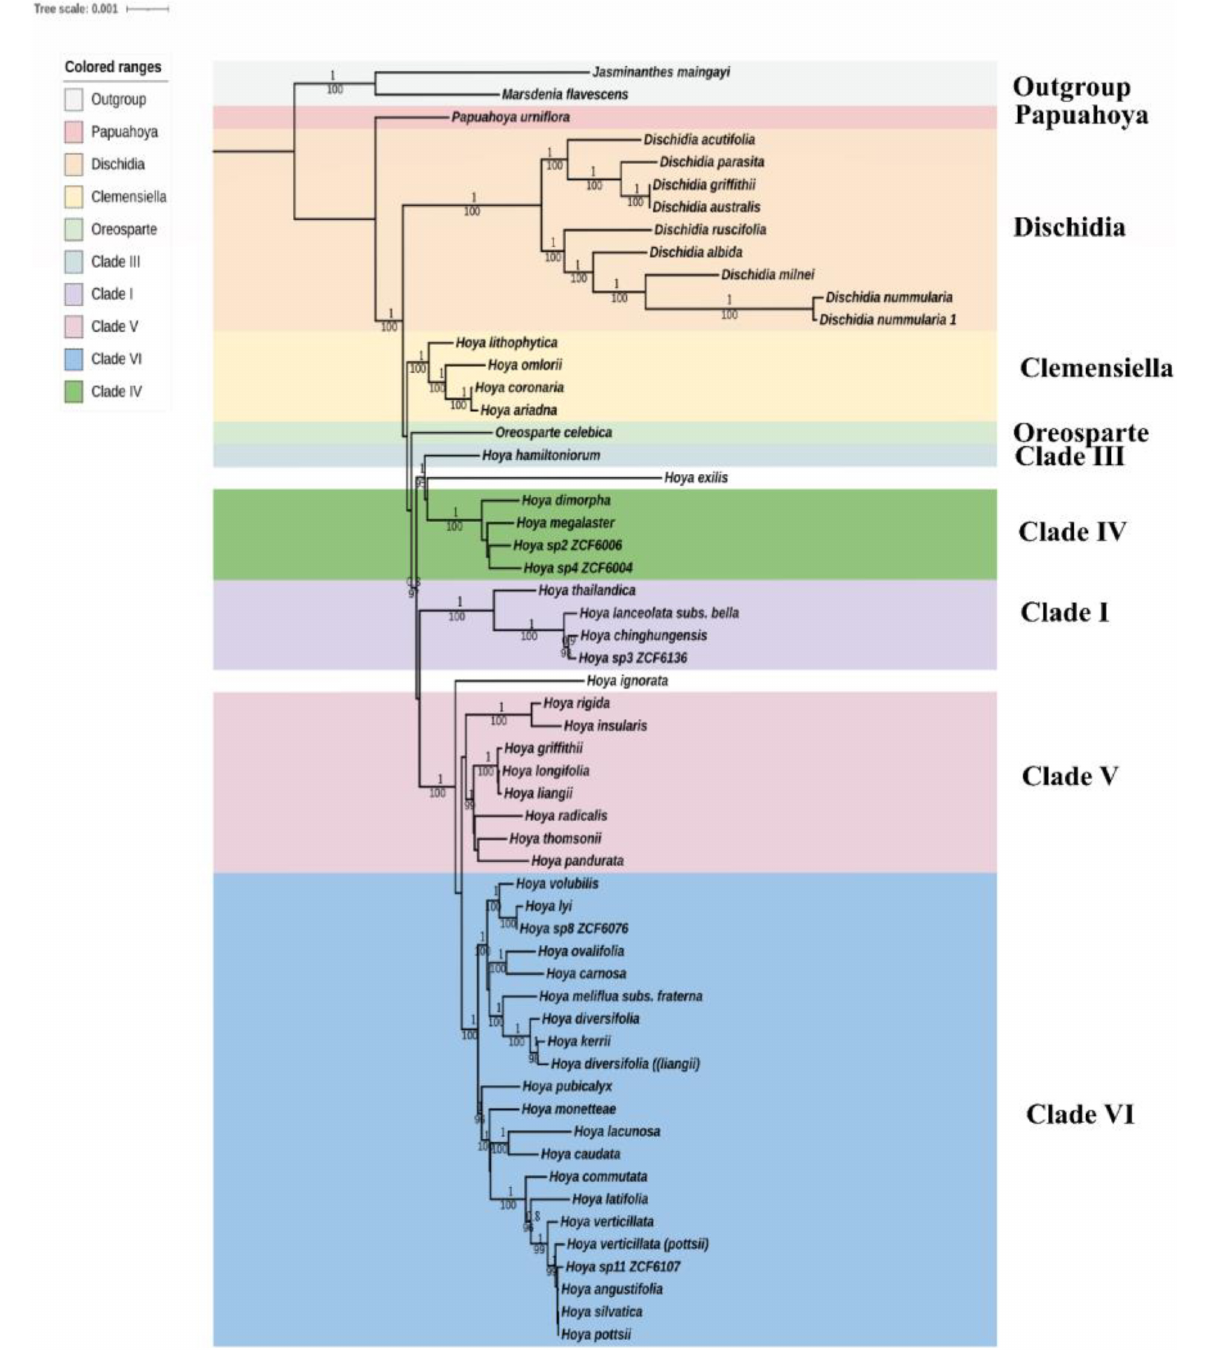
FIGURE 5 | Phylogenetic tree of Hoya inferred from 57 species using ML. CDS tree reconstruction is rooted with Marsdenia and Jasminanthes as outgroups. Bootstrap support values and Bayesian inferred posterior probabilities are given below and above the branches, respectively. Different colors represent different clades following Wanntorp et al. (2014) and Rodda and Niissalo (2021).